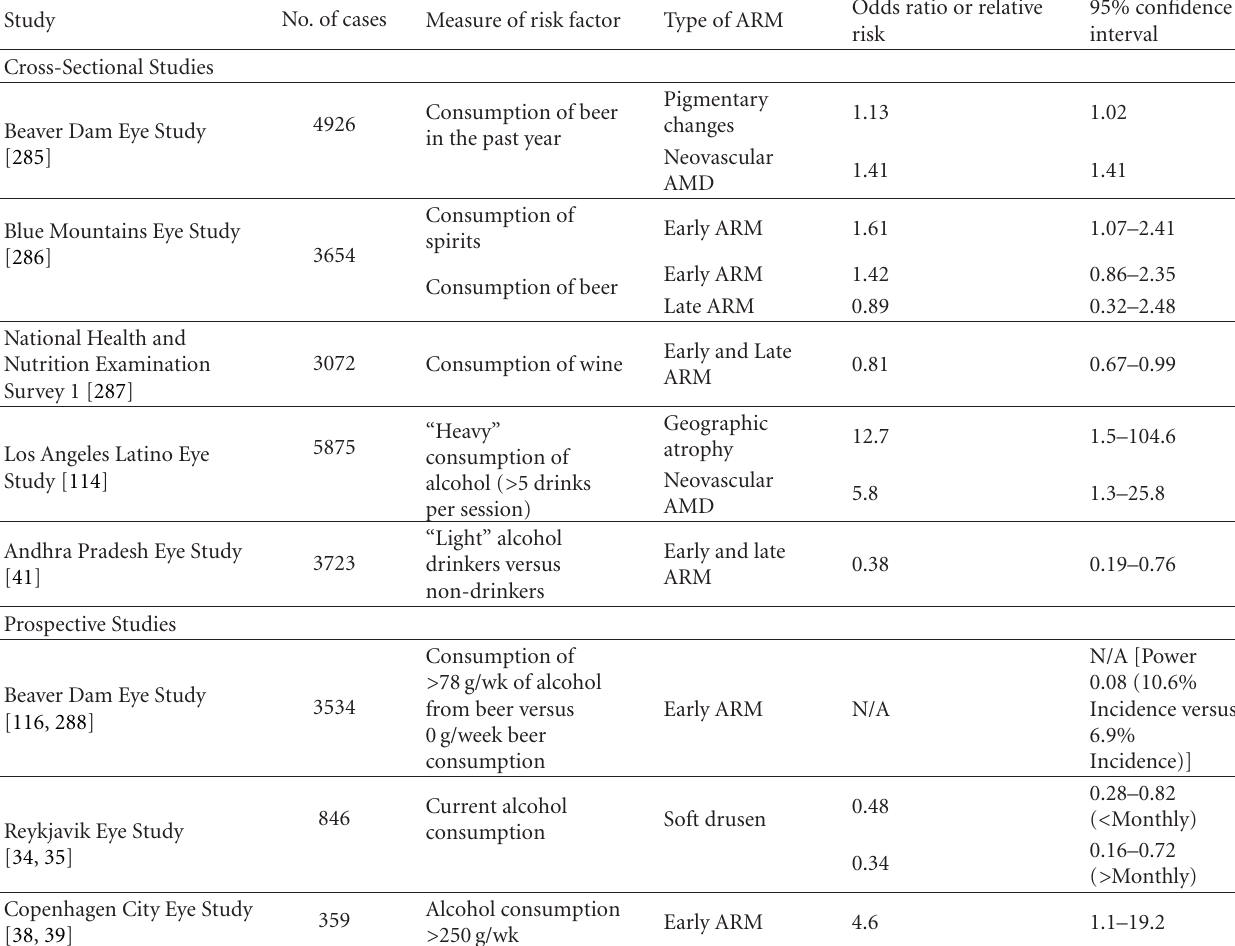
Table 20: Studies investigating the relationship between alcohol and risk for